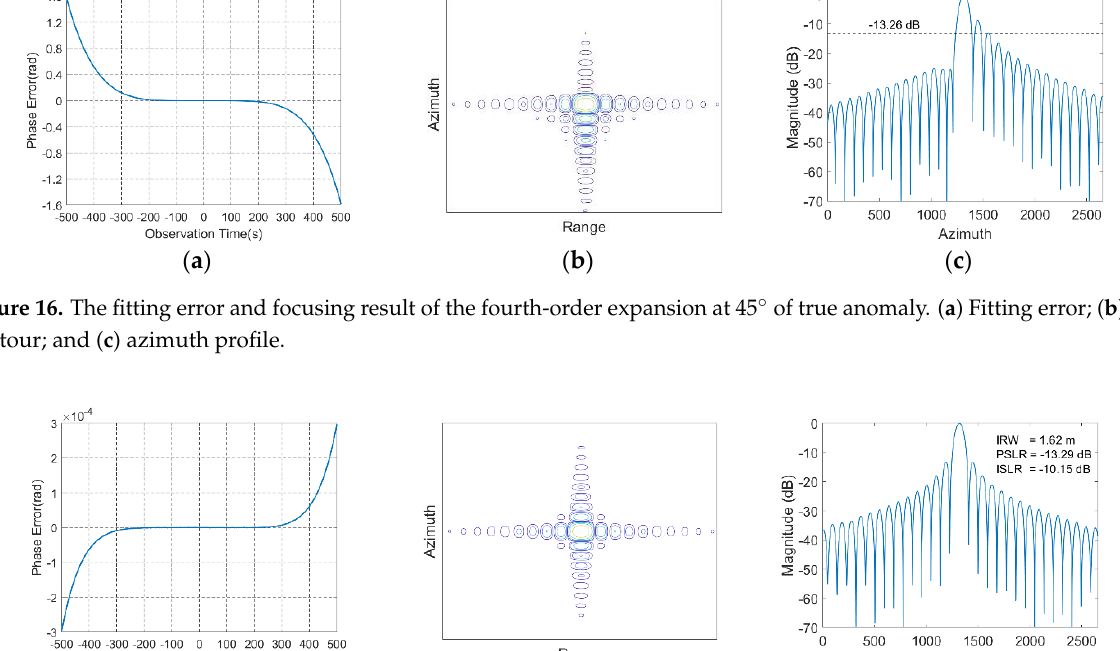
Figure 18. The fitting errors of the sixth-order Taylor expansion with 2000 s observation time at different orbit positions.